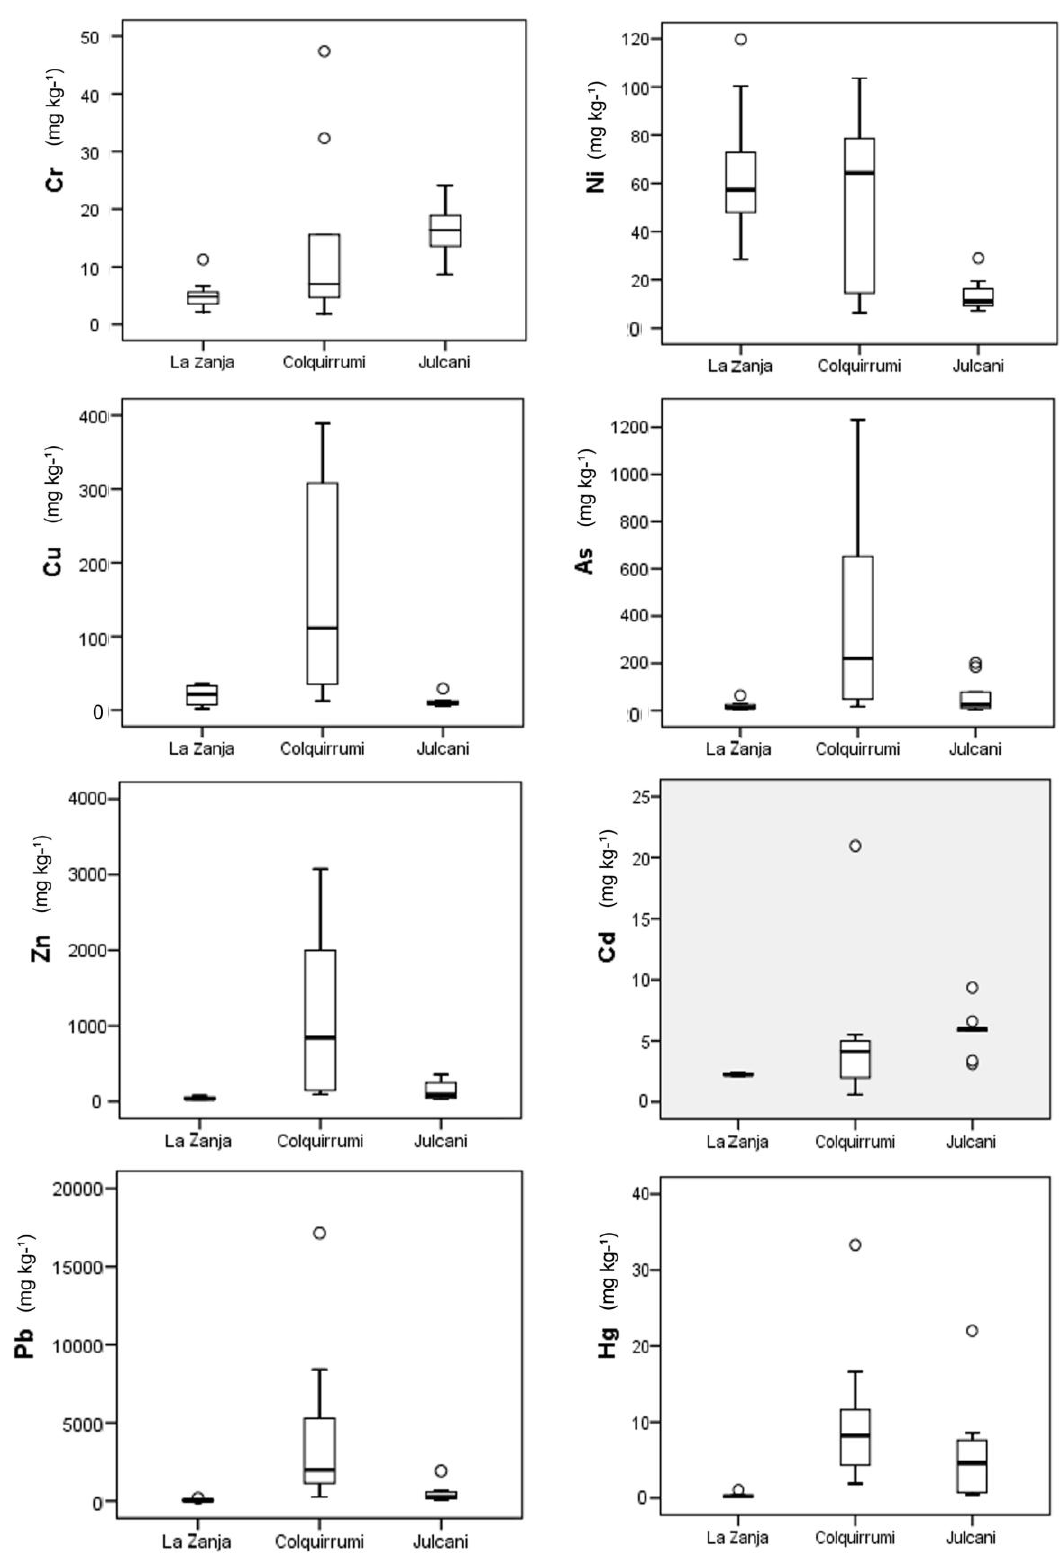
Figure 4. Box and whisker plots of heavy metal concentrations.